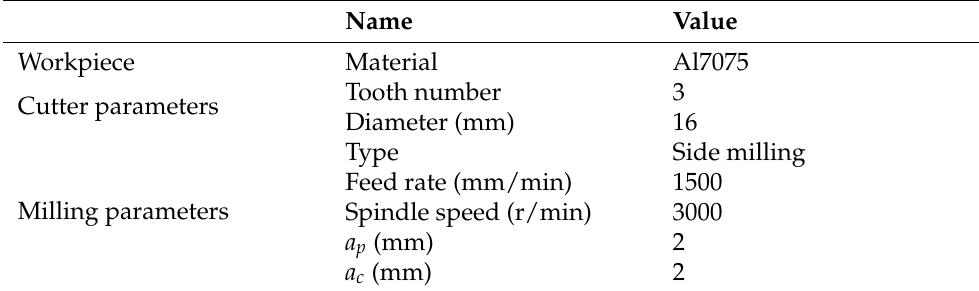
Table 2. The main parameters in the machining process.